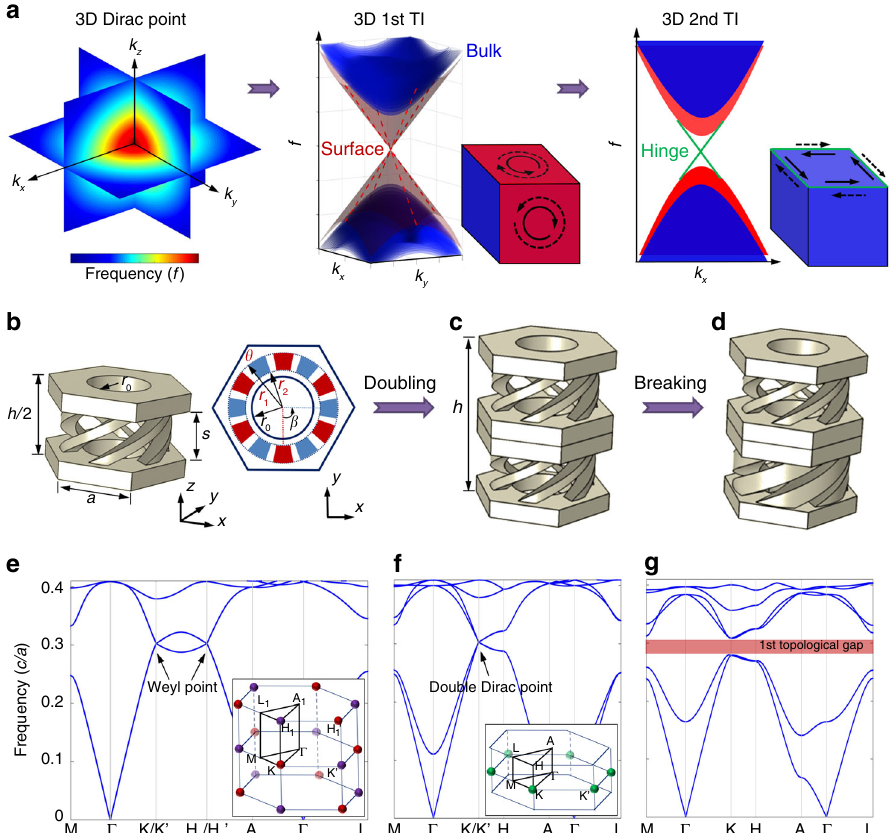
Fig. 1 From Dirac cones to 3D 1st- and 2nd-order acoustic analogues of TIs. a Left side: visualization of a 3D Dirac cone for bulk bands, where the colour scale represents frequency. Middle: 1st-order TI case by splitting the bulk Dirac degeneracy, where the red planes show the 2D topological surface states. Right side: 2nd-order TI case after further splitting the surface degeneracy, where the green lines show the 1D gapless hinge states. b Single-layer unit cell and top-down view of the honeycomb lattice with the chiral structures wherein sound propagates. The structure parameters are h = 7/ a, s = 2/ a , and r 0 = ffiffiffi p ffiffiffi p a /2 − 0.2 cm, r 2 = r 0 + 0.2 cm and θ = 15° with spiral angle β = 90°. The 1.3/ a , where a = 3 cm. The parameters of the spiral channels a r e r 1 = 3 colours blue and red represent the bottom and top channels, respectively. c Bilayer unit cell case. d Breaking the h/ 2 spatial translation symmetry by ffiffiffi p a /2 − 0.05 cm, r = r + 0.05 cm and θ = 40°. e – g The bulk bandstructures corresponding to the enlarging the spiral channels of the lower layer to r 1 = 3 2 0 unite cells in panels b – d , respectively. The insets show the Brillouin zones, where the red and purple dots denote the Weyl points with opposite charges and the green dots denote the 3D double degenerate Dirac